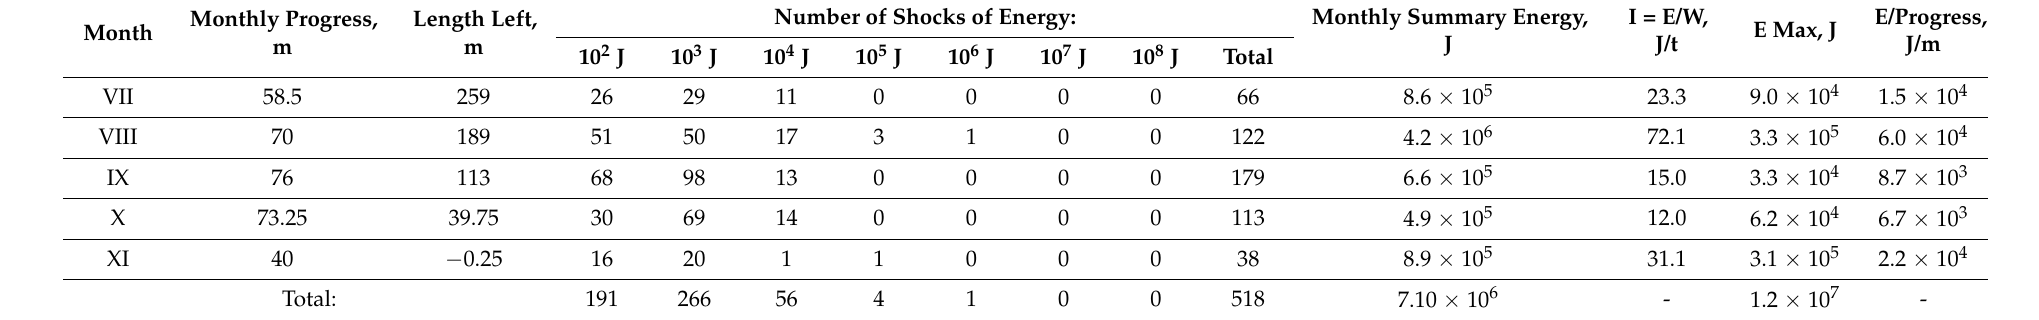
Table 3. Shocks registered during the exploitation of coal seam 713/1-2 at longwall II-E1 during the performance of DHF from July 9th until November 19,